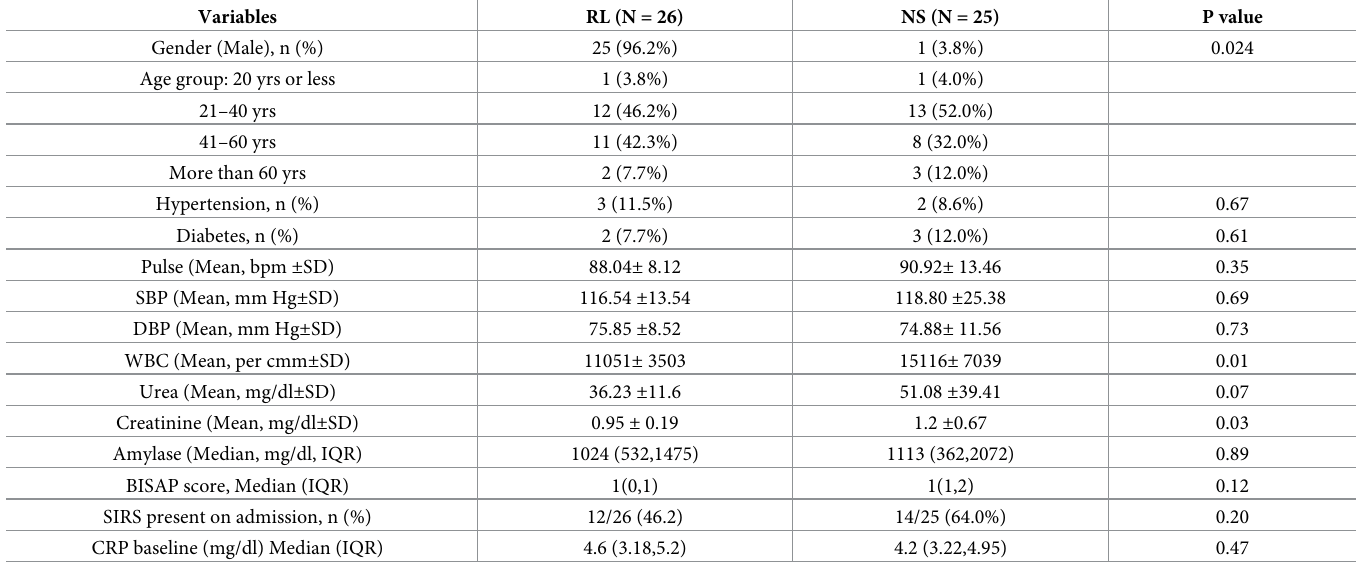
Table 1. Baseline characteristics of the study population.